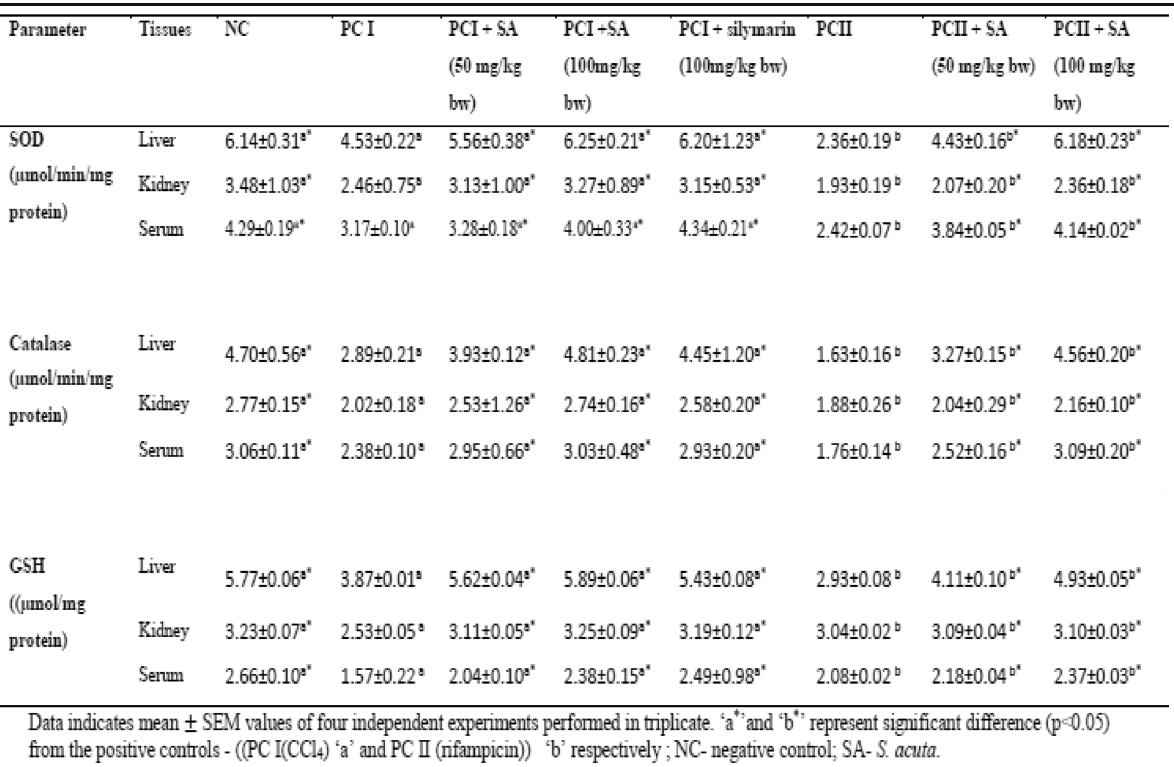
Table 4 Effect of S. acuta extract on selected antioxidant enzymes in the liver and kidney of rats exposed to CCI 4 and rifampicin